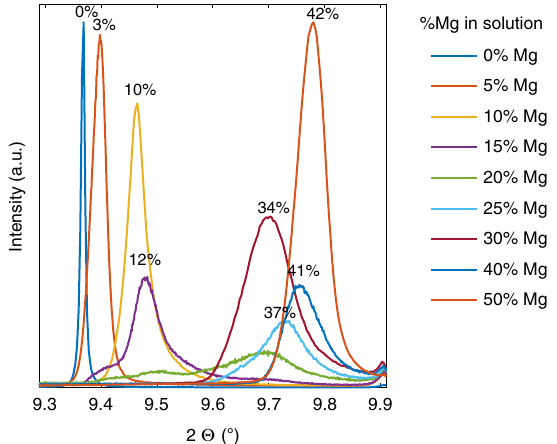
Fig. 7 Instability of Mg-CaCO 3 for a range of Mg composition. (104) XRD peak from Mg-calcite crystallized from hydrothermally treated Mg-ACC in solution. Data were acquired by synchrotron radiation ( λ = 0.496 _ A ). Numbers near the peaks are the η (Mg/Ca + Mg) in the calcite crystals, obtained from the re fi ned lattice parameters and the equations linking the lattice parameters and η obtained by Zolotoyabko et al. 24 . The diffractograms are normalized to the highest diffraction peaks (calcite (104) peak for the powders precipitated from solutions containing 0 or 50% Mg in solutions, and aragonite peak for the other powders) NATURE COMMUNICATIONS| (2019) 10:4559